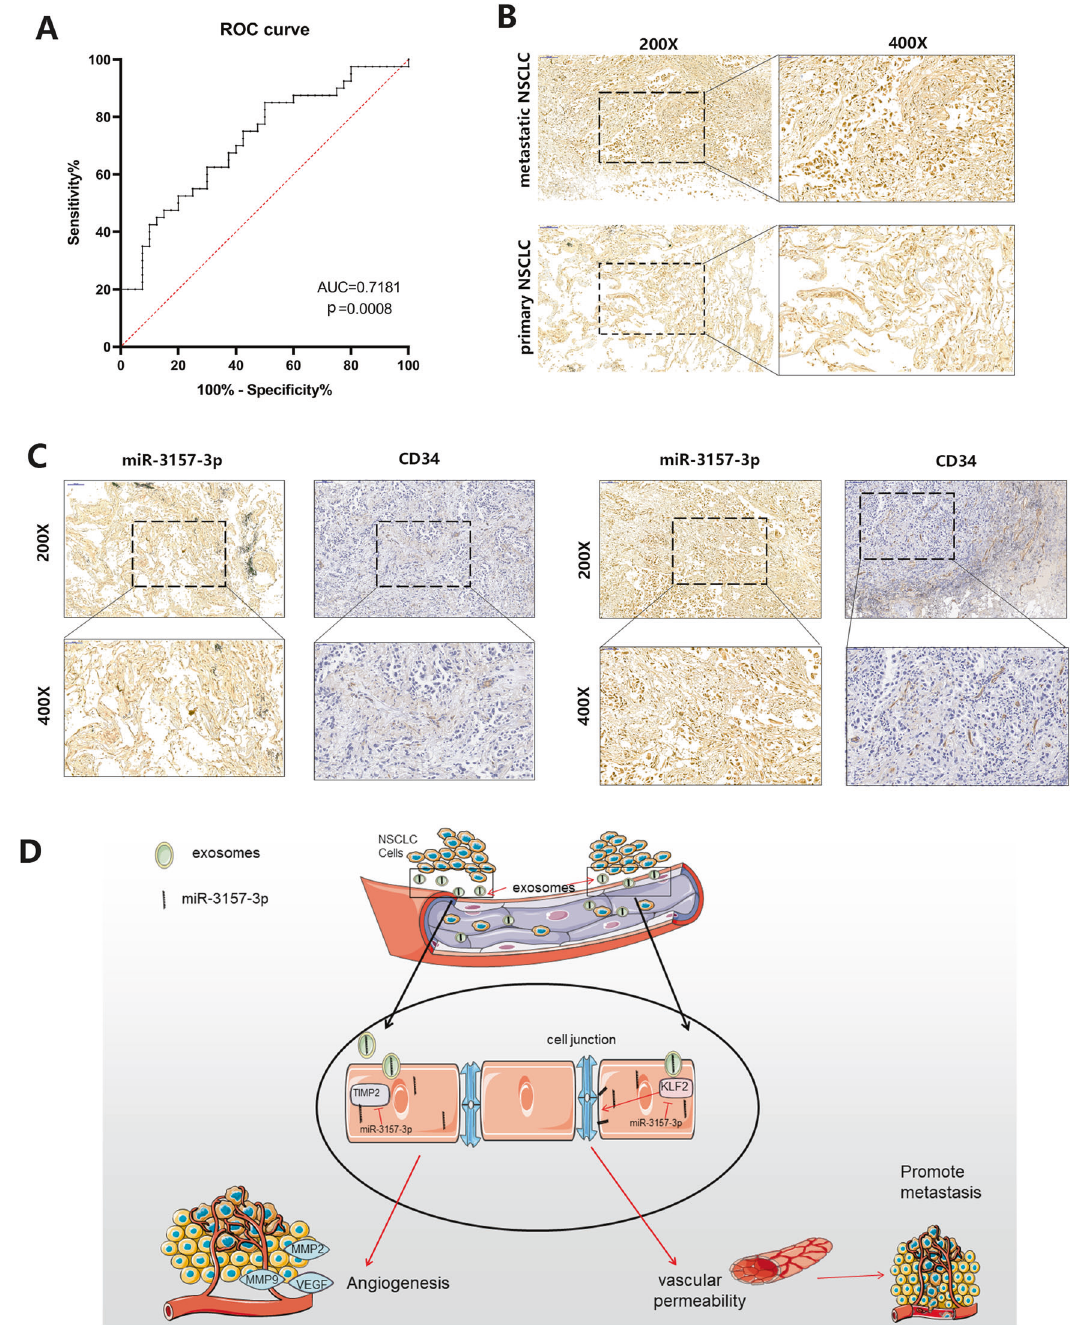
Fig. 8 Exosomal miR-3157-3p is associated with NSCLC metastasis. A ROC curves were used to evaluate whether exosomal ‐ miR ‐ 3157-3p acts as a biomarker. B Representative images of in situ hybridization for miR-3157-3p in the tissues with or without metastasis. C Representative images of miR-3157-3p IHC for CD34 with high or low expression levels of miR-3157-3p. The scale bar in 200× images represents 100 µm. The scale bar in 400× images represents 50 µm. D Schematic diagram of the role of NSCLC-secreted miR- 3157-3p in pre- metastatic niche formation. The data are shown as the mean ± inhibitor of MMP activity and inhibits angiogenesis. In NSCLC, both miR-3157-3p is abnormally expressed in NSCLC patients, KLF2 and TIMP2 are down-regulated. Our results showed that miR- especially those with metastases. We found that miR-3157-3p in 3157-3p in HUVEC can absorb exosomes downregulates KLF2 and vascular endothelial cells can induce vascular permeability and TIMP2, and subsequently reduce its downstream target, occludin, angiogenesis by down-regulating KLF2 and TIMP2. Kruppel-like and increase the levels of VEGF/MMP2/MMP9. Our data indicate factors (KLFs) are a subclass of the zinc fi nger family of DNA- that the exosome miR-3157-3p secreted by NSCLC promotes binding transcription factors. KLF2 can regulate the key tight vascular permeability and angiogenesis by silencing KLF2 and junction protein occludin in endothelial cells to maintain the TIMP2 (Fig. 8D). integrity of the endothelial barrier function. TIMP2 is a natural